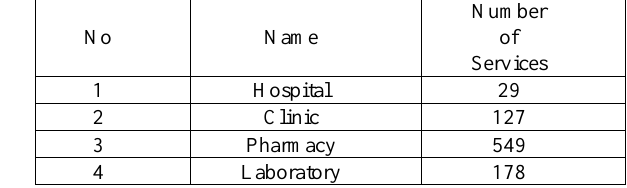
Table 1. Table 1: List of Data.